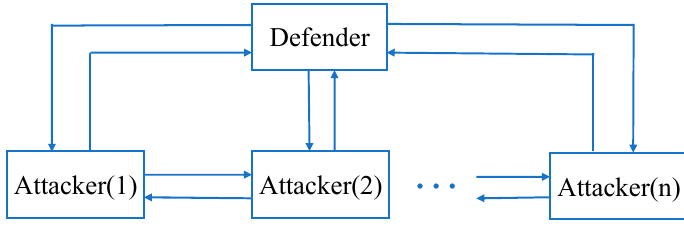
Figure 2. Multi-player game in network attack and defense. Table 1. Meanings of the variables in the multi-player game.